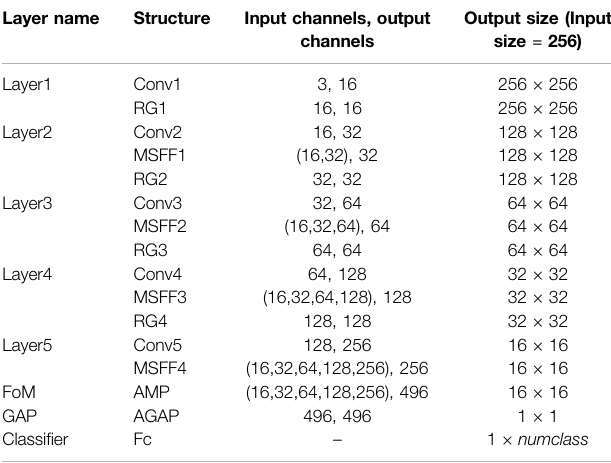
TABLE 2 | Detailed structure of MSDFN. “ Conv ” , convolutional layer; “ RG ” , residual group; “ AMP ” , adaptive maximum pooling; “ AGAP ” , adaptive global average pooling; “ Fc ” , fully connected layer; “ numclass ” , the number of fault categories.